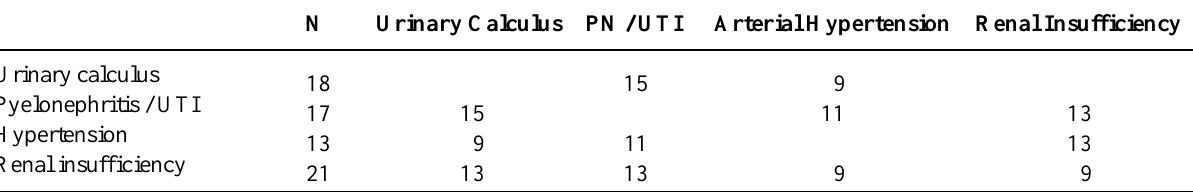
Table 2 – Association between renal insufficiency and arterial hypertension in rats with urinary calculus and pyelone-